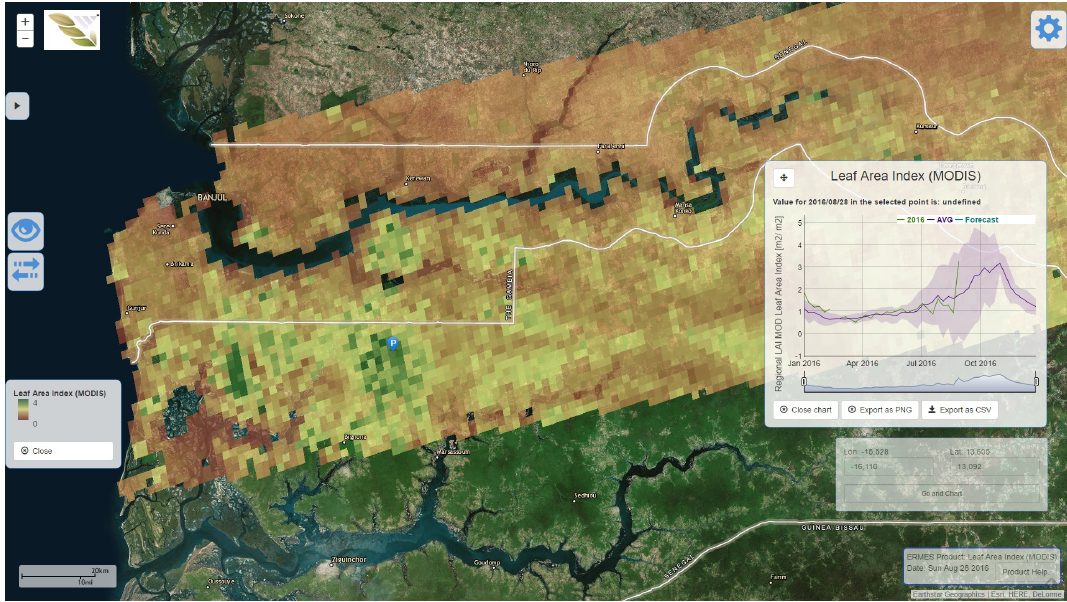
Figure 5. Normalized difference vegetation index (NDVI) product visualization in Gambia